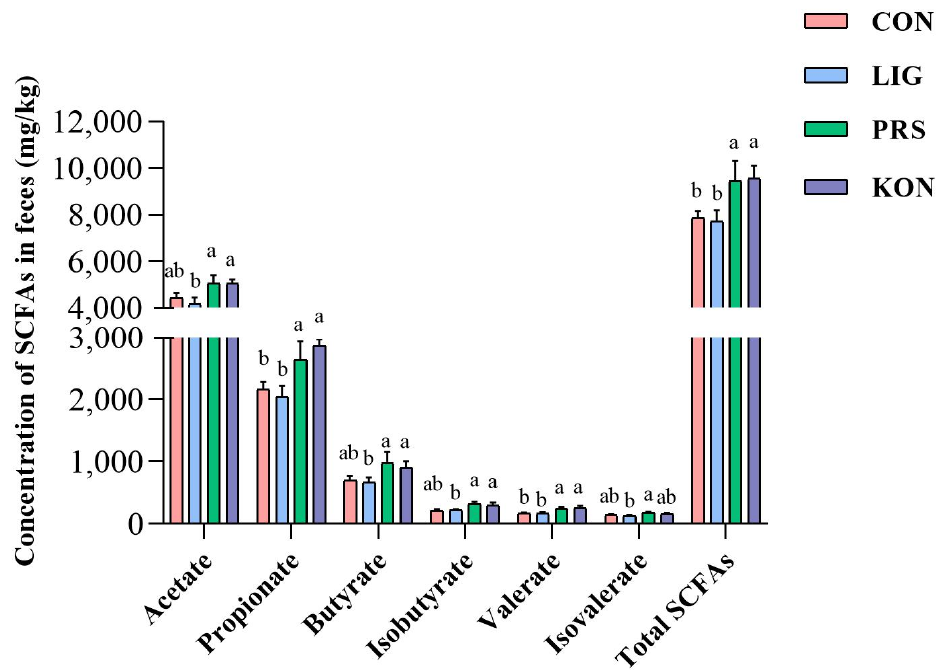
Figure 6. Characteristics of the short-chain fatty acids (SCFAs) profile in the feces of sows after dietary fiber treatment ( n = 7). CON, control; LIG, lignocellulose; PRS, resistant starch; KON, konjaku flour. Differences in superscript letters for the peer data indicate that the difference is significant ( p < 0.05).